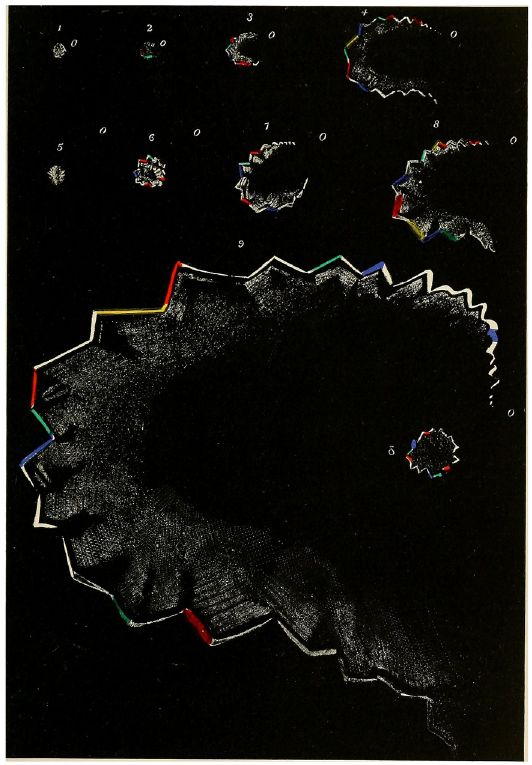
Figure 1. Example of a migraine aura. This picture illustrates the typical gradual expansion of a migraine aura along with the characteristic fortification